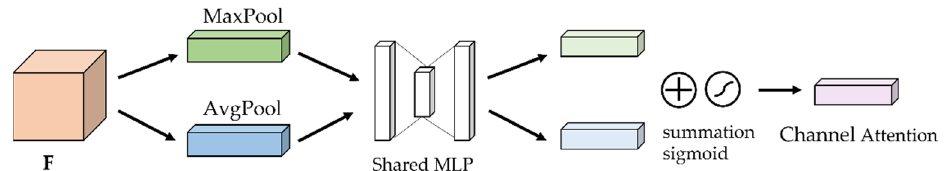
Figure 5. The structure of the Channel Attention Module.